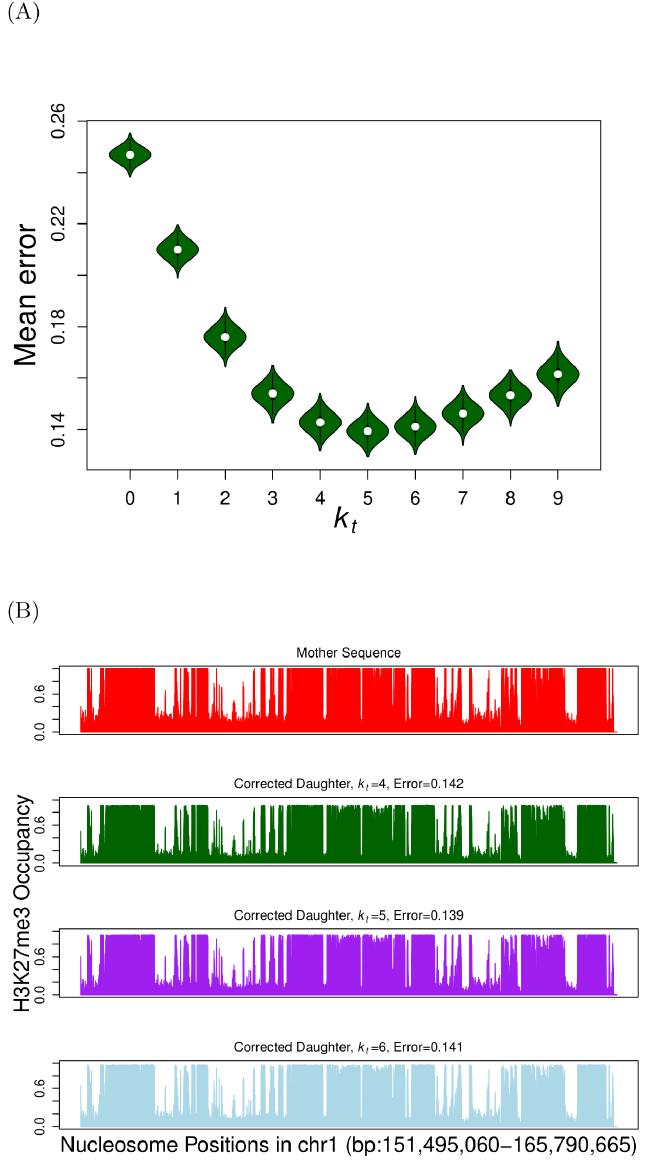
Fig 5. Error Correction in H3K27me3 data (A) Mean deviation ( � D ) between corrected daughters and corresponding mothers, where the experimental population-averaged parental data for H3K27me3 is from [28] (see database GEO: GSE110354). Error correction was performed using the threshold- k filling algorithm for different k t values. (B) The population averaged histone modification occupancy for H3K27me3 is plotted for mother sequence (top), and corrected daughter sequences corresponding to different values of k t